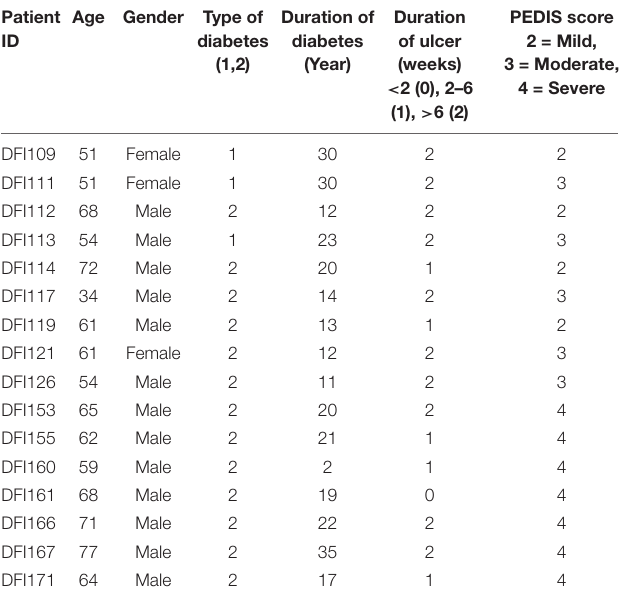
TABLE 1 | Demography of recruited patients in this study.